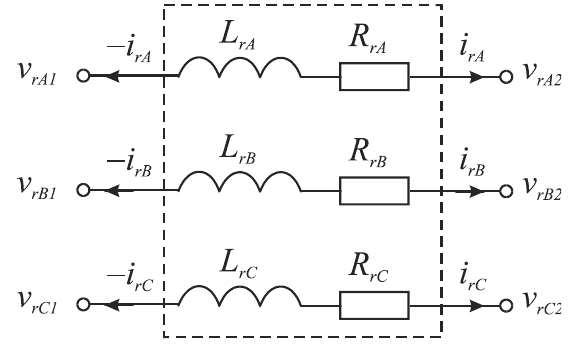
Figure 3. Scheme of three-phase choke.